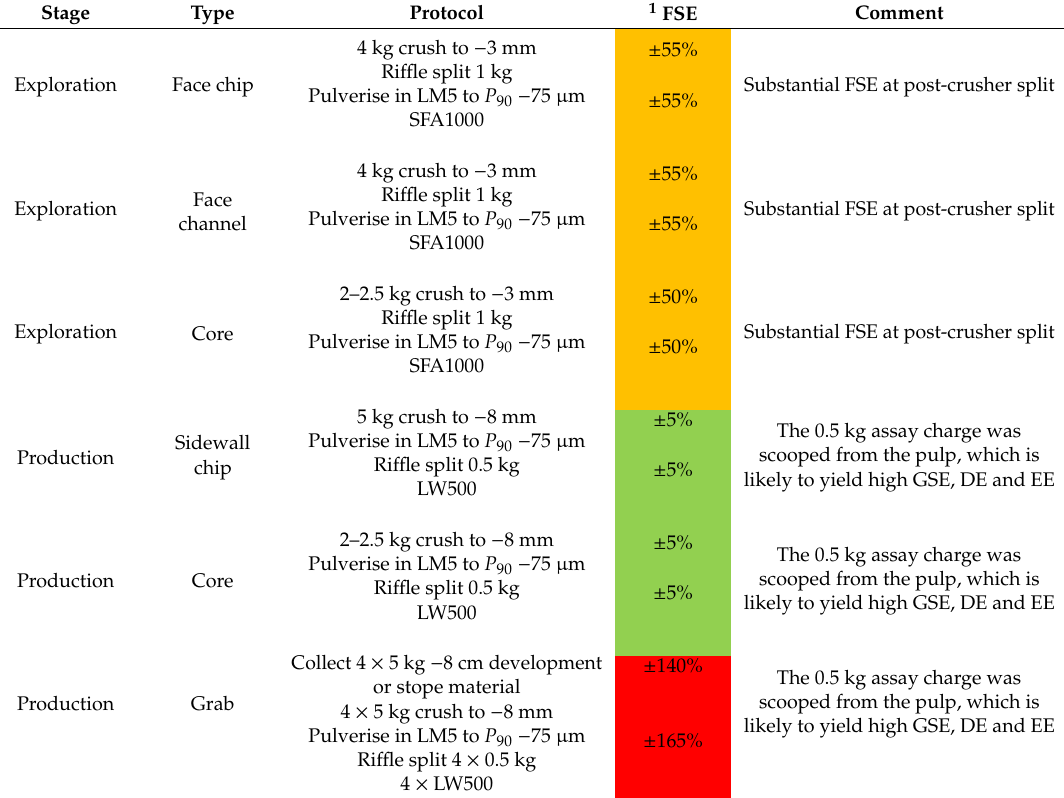
Table 29. FSE for exploration/evaluation and production protocols at Nalunaq. Calculations based on the BCOG and run of mine grade (non-clustered) scenarios in Table 28. FSE calculations assume coarse gold in the pulp.